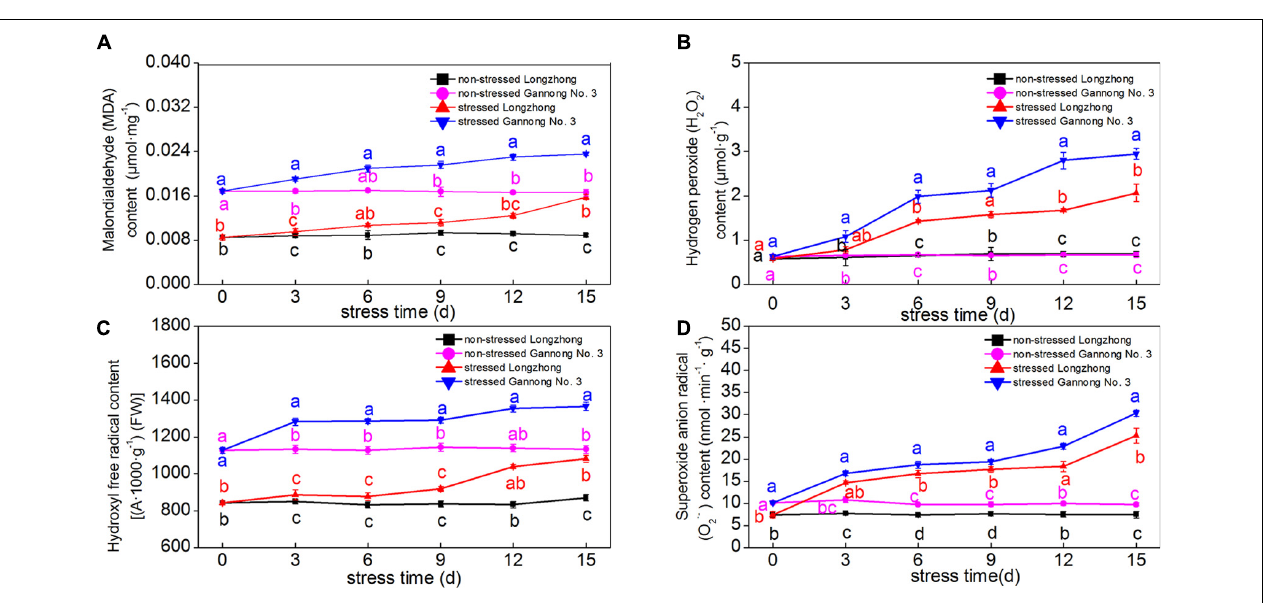
FIGURE 2 | Changes of the levels of MDA, H 2 O 2 , OH • and O 2 •− (A–D) in two alfalfa varieties under non-stressed and stressed conditions at different time points. Different letters above line graphs indicate significant difference among treatments at a given day of treatment ( P ≤ 0.05), and vertical bars indicate ± SE of mean ( n =